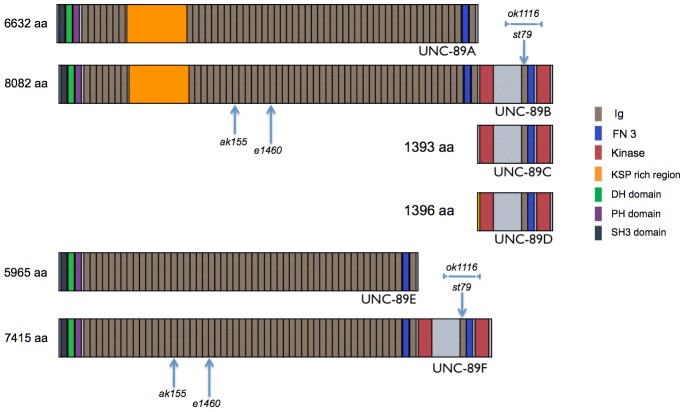
Comparison of UNC-89 isoforms.Schematic of UNC-89 isoforms. The arrows indicate the location of the unc-89(ak155), unc-89(e1460) and unc-89(st79) stop codons. The blue line underlying ok1116 indicates the deleted region in unc-89(ok1116) mutants.